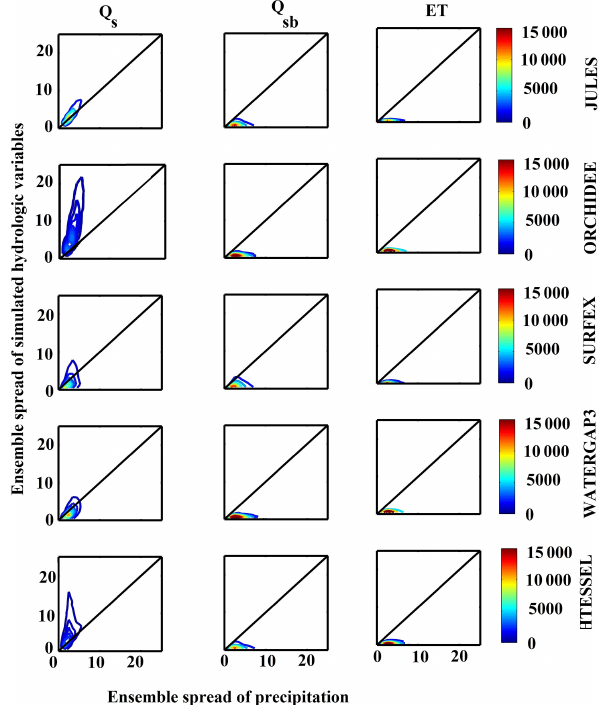
Figure 14. Density contour plot of the relationship between ensem- ble spread of simulated hydrological variables and precipitation at monthly scale. Color scale shows the frequency of occurrence. The black line is the 1 : 1